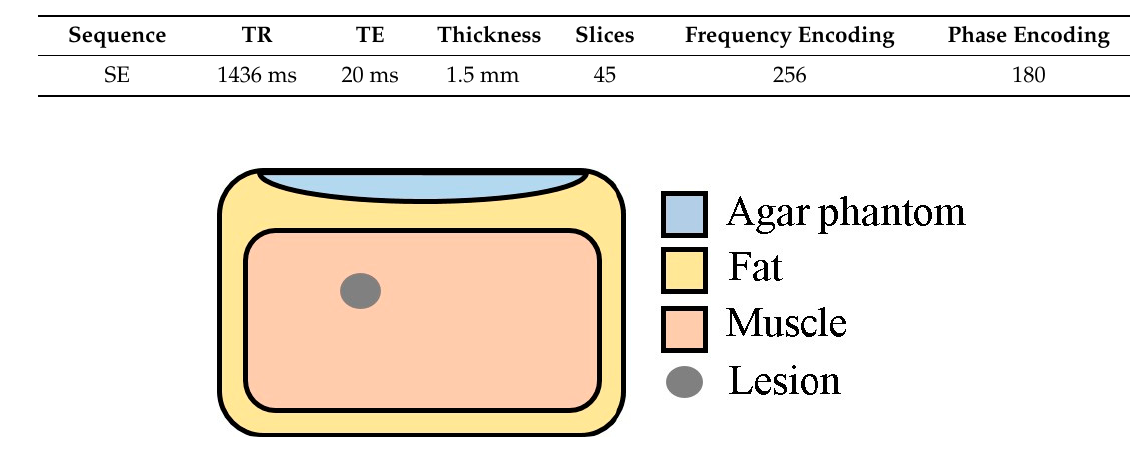
Figure 4 Composition of the phantom used in the experiment. Figure 4. Composition of the phantom used in the